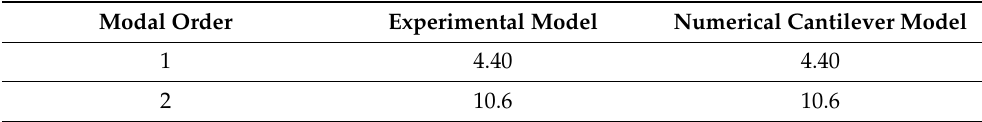
Table 4. Comparison of the natural frequencies of the structure before the main earthquake